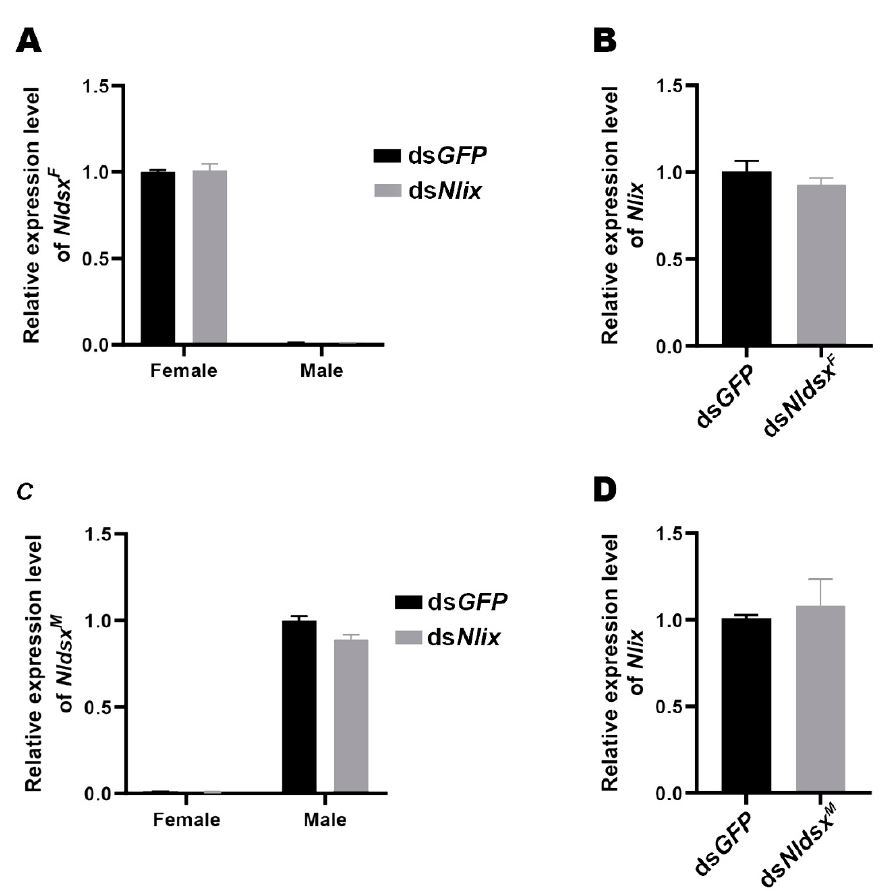
Figure 8. No correlation was found regarding the expression level between Nlix and Nldsx . ( A , C ) Knockdown of Nlix produced no obvious effect on the level of female-specific isoform Nldsx F or male-specific isoform Nldsx M . ( B , D ) The Nlix expression was unaffected in the ds Nldsx F -treated females or ds Nldsx M -treated males. The values were calculated from three biological replications (mean±SEM).